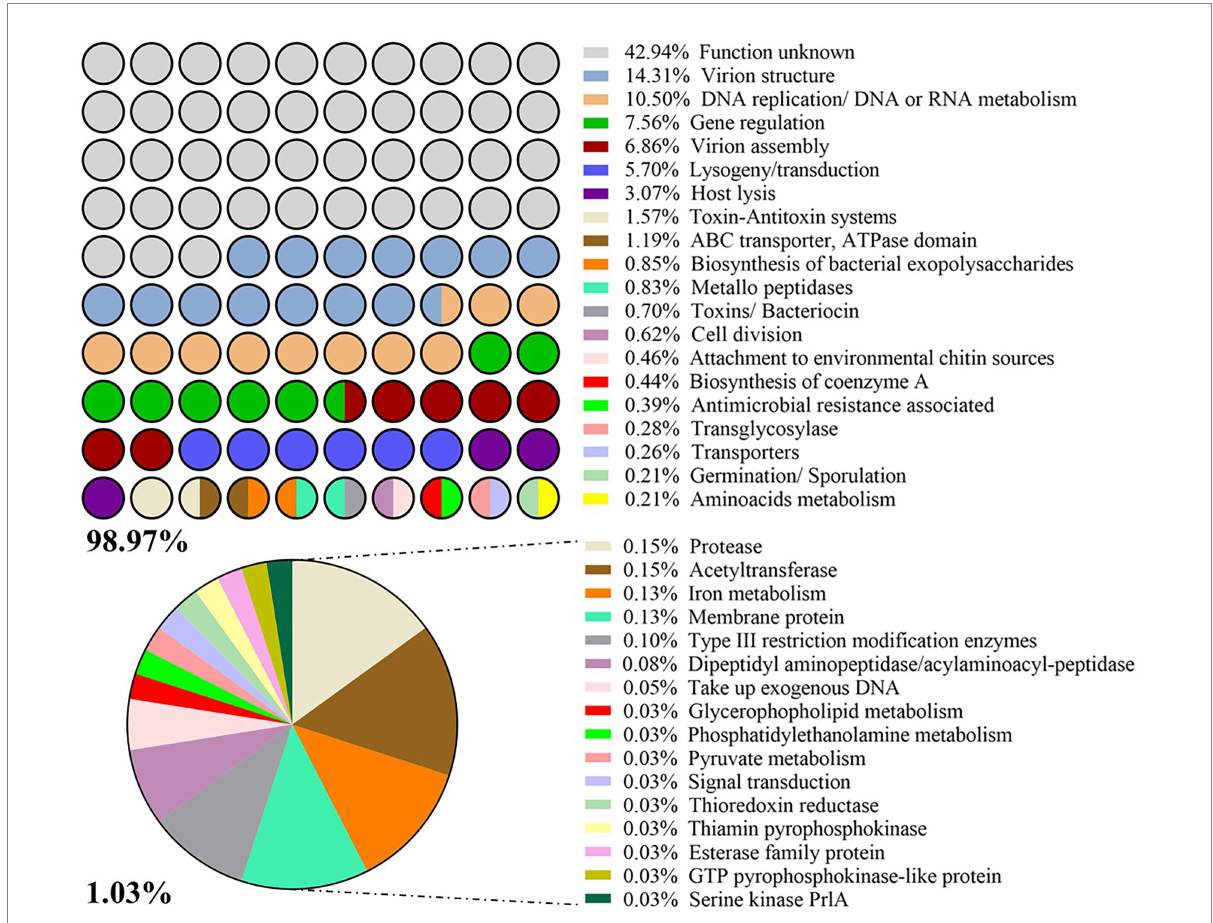
FIGURE 4 List of categories Cluster of Orthologous Groups (COG). Frequency (%) of prophage-derived CDS with a given function per